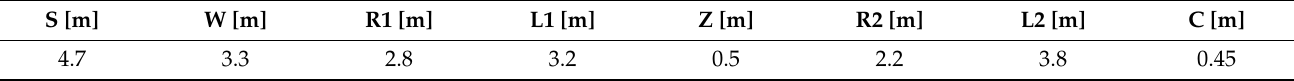
Table 1. Data for arch yielding support